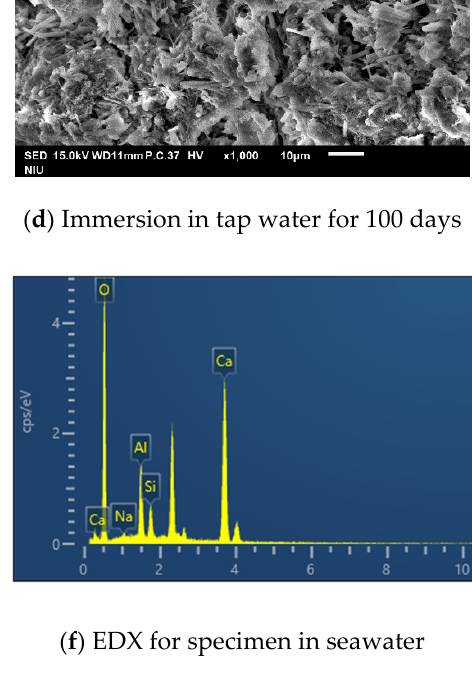
Figure 8. SEM photos